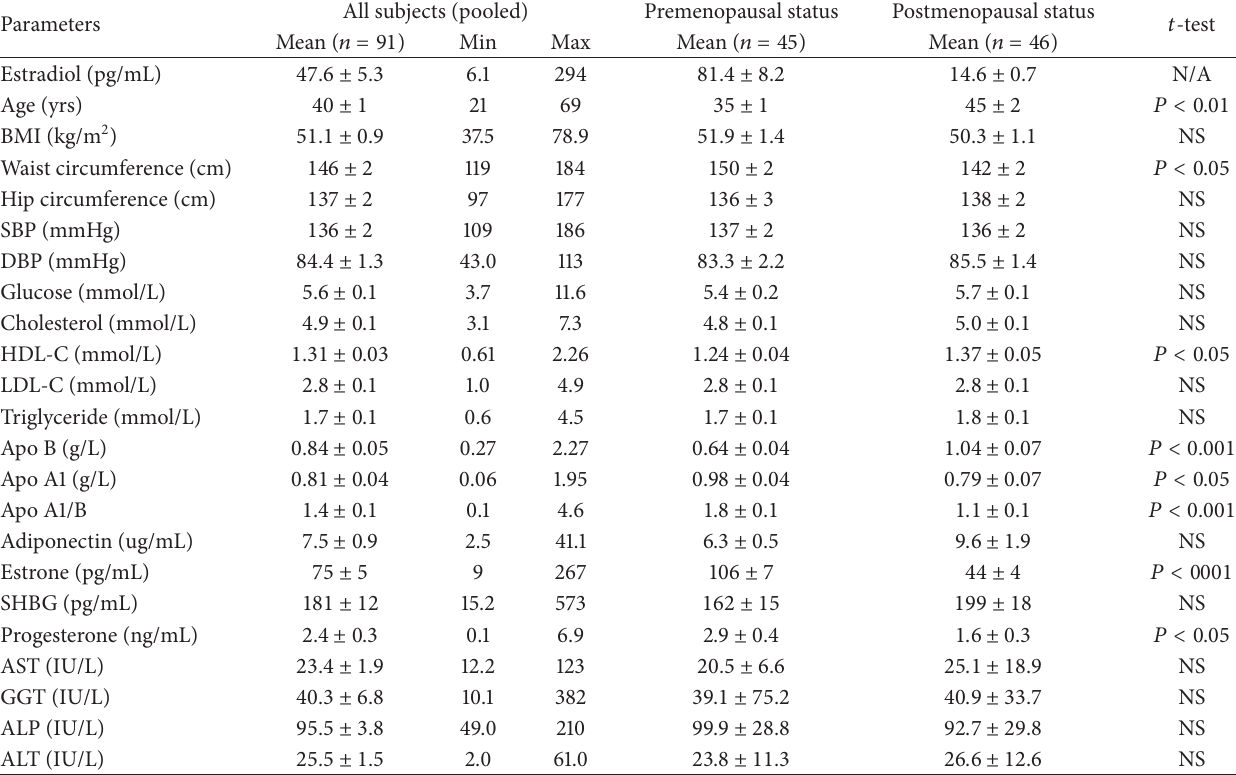
Table 1: Characteristics of pre- and postmenopausal Obese